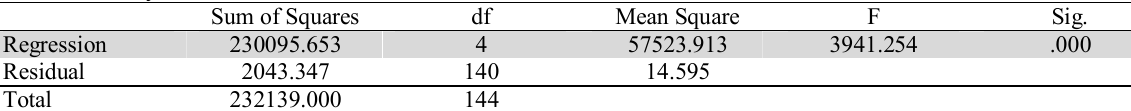
The summary of ANOVA test Sum of Squares